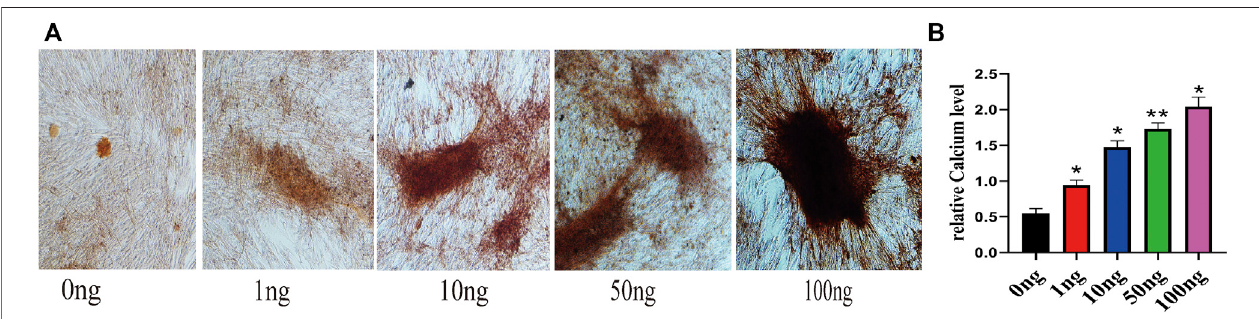
FIGURE 1 | IL-18 promotes the osteogenic differentiation of hBMSCs. hBMSCs were treated with different concentrations of IL-18 for 7 days and calcium depositionwasevaluatedusingAlizarinRedstaining (A) andquantitativecalciumassayisusedtomeasurecalciumconcentration (B) .Dataareexpressedasthemean ± standard deviation (SD). Concentration groups vs. the control (0 ng) group. Experiments were repeated three times. Scale bars: 200 μ m for A, p p < 0.05, pp p < 0.01.